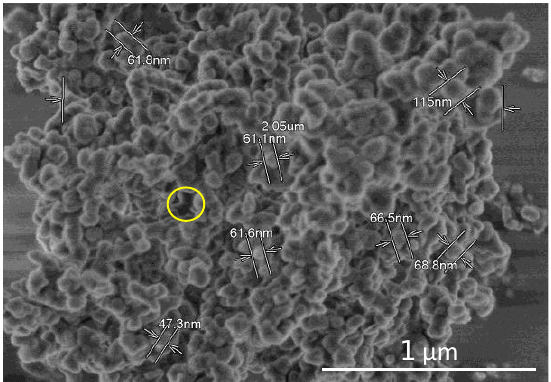
Figure A3. Representative SEM image of NH 2 -MIL-53(Al) material (prepared at room temperature after 24 h and using NaOH 1 M as a deprotonating agent) showing average particle size (i.e., white circle), and intercrystalline mesoporosity in between the particles (i.e., yellow circle).